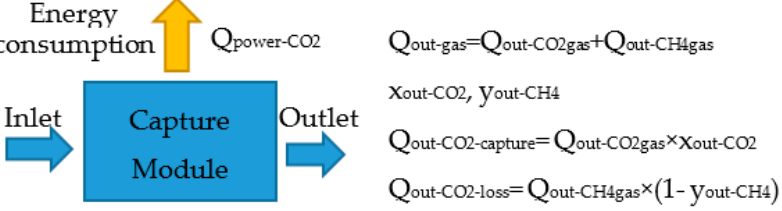
Figure 4. Variation of CO 2 flow through capture module. Table 2. CO 2 flow variation and CO 2 capture efficiency of each equipment unit in CCRP. Equipment